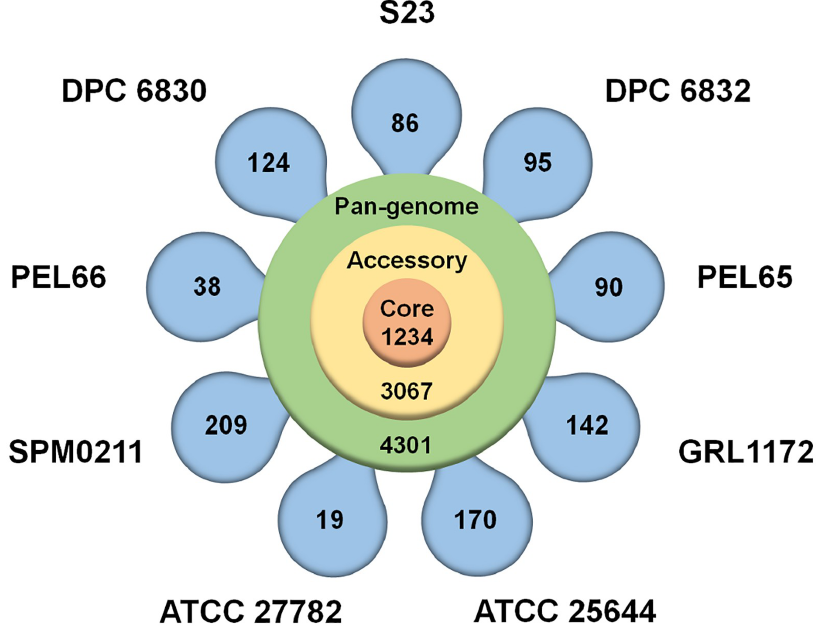
Fig 2. Pan-genome of the nine L . ruminis strains. A flower-plotdepictingthe gene content in the pan- (4301), core (1234), and accessory (3067) genomesof L . ruminis is shown. The number of strain-specific genesper genome is shown in the flower petals. Names for each L . ruminis strain are indicated.Annotated core and accessory genesare providedin the S1 Table.